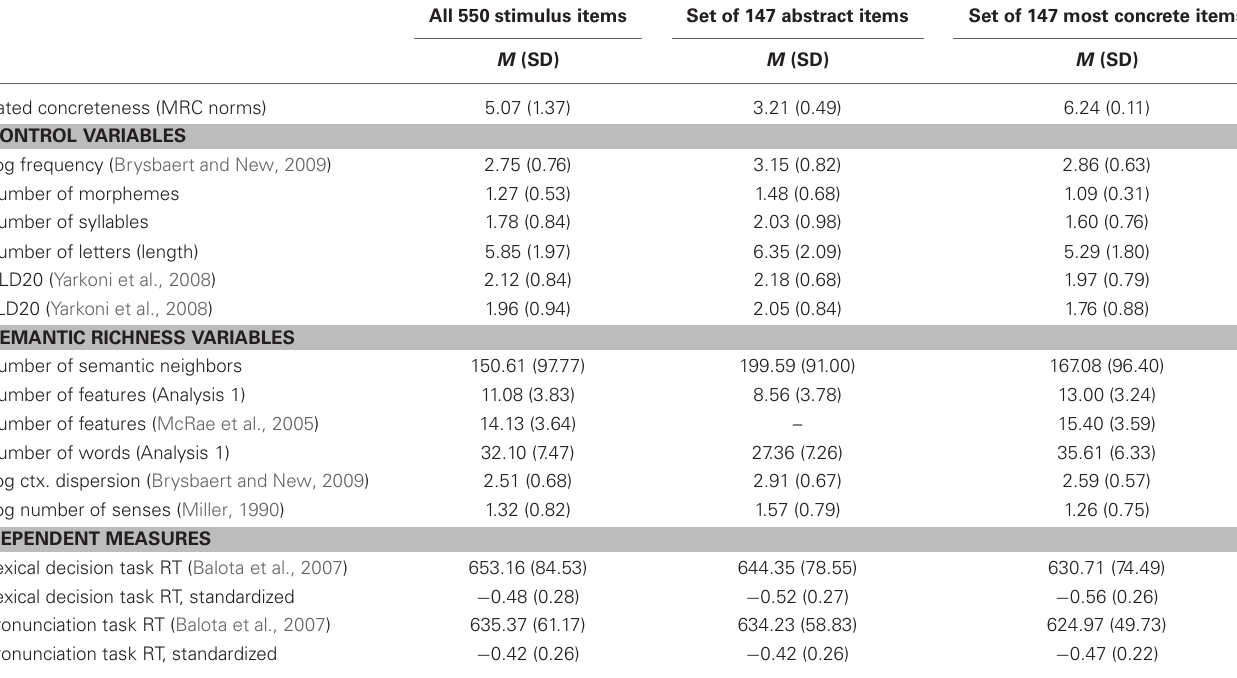
Table 1 | Descriptive statistics for stimulus characteristics (predictors and dependent